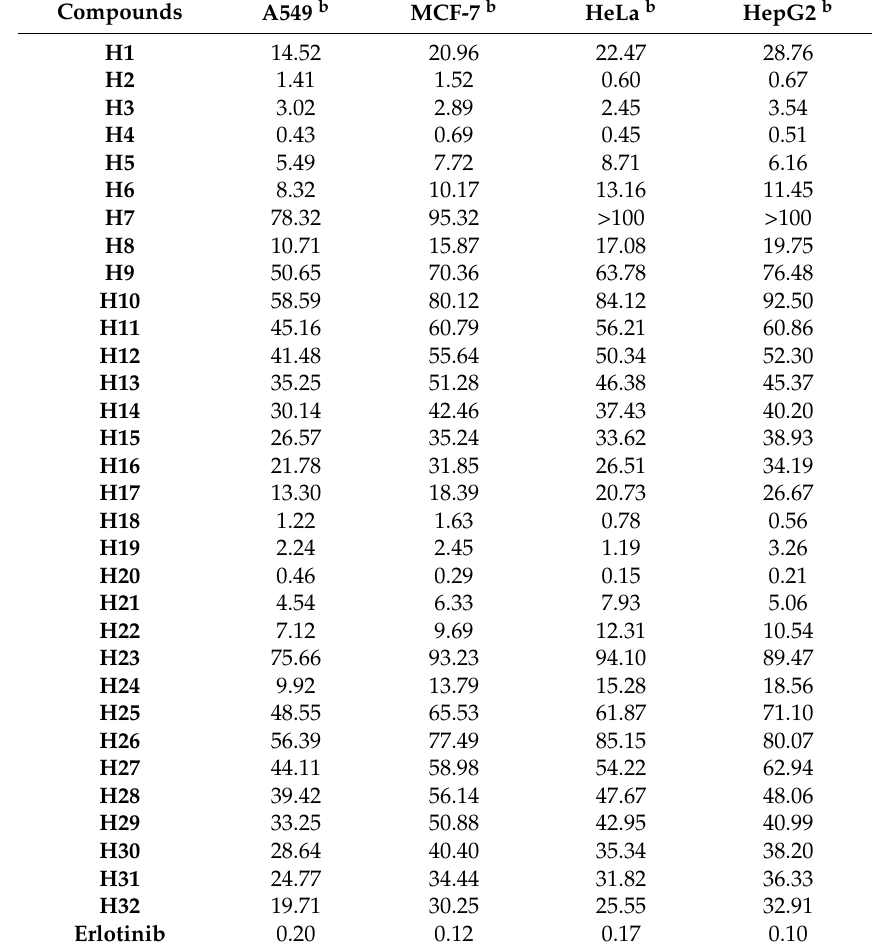
Table 2. In vitro antiproliferative activities (IC 50 , µ M a ) of all compounds against tumor cell